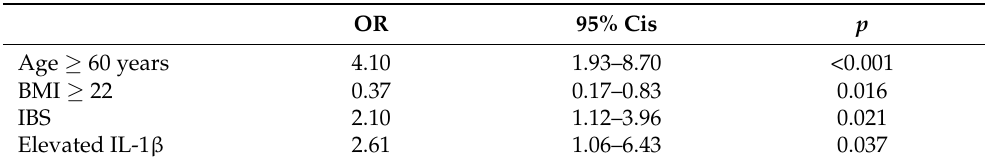
Table 3. Multivariate forward stepwise logistic regression analysis of statistically significant factors independently related with